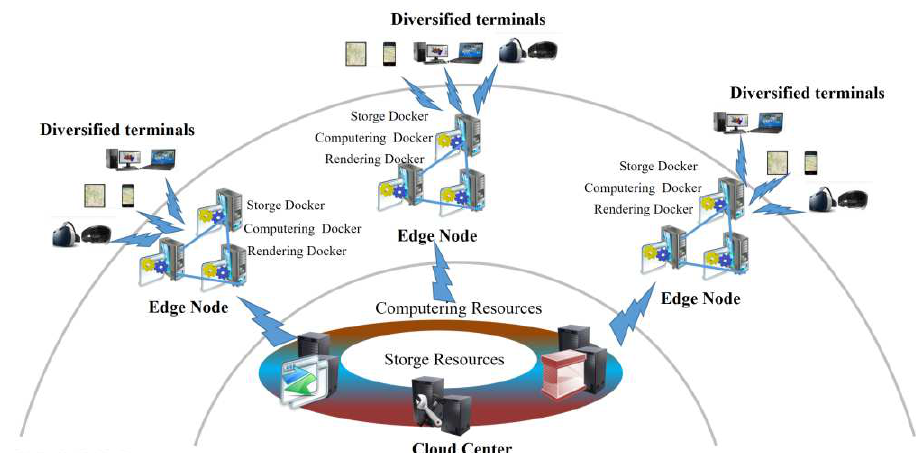
Figure. 2 The cloud-edge-terminal microservice architecture of prototype system The traditional integrated GIS architecture has many problems, such as centralized deployment, high coupling between components, and difficult to maintain and continuously